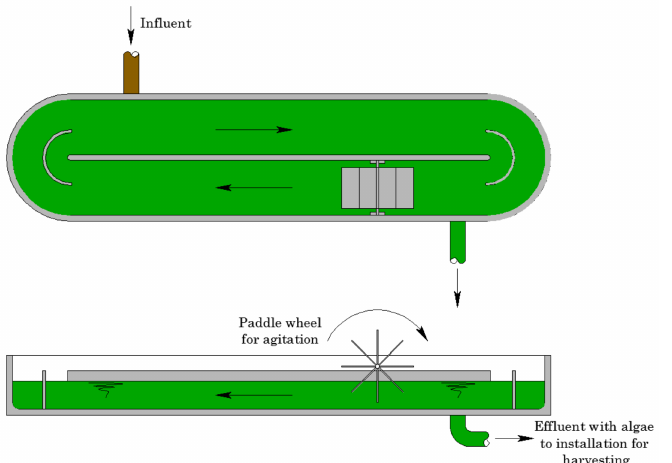
Figure 3. Open Raceway pond scheme adapted from Arbib et al, 2017 and Sutherland et al., 2020 [42,45].